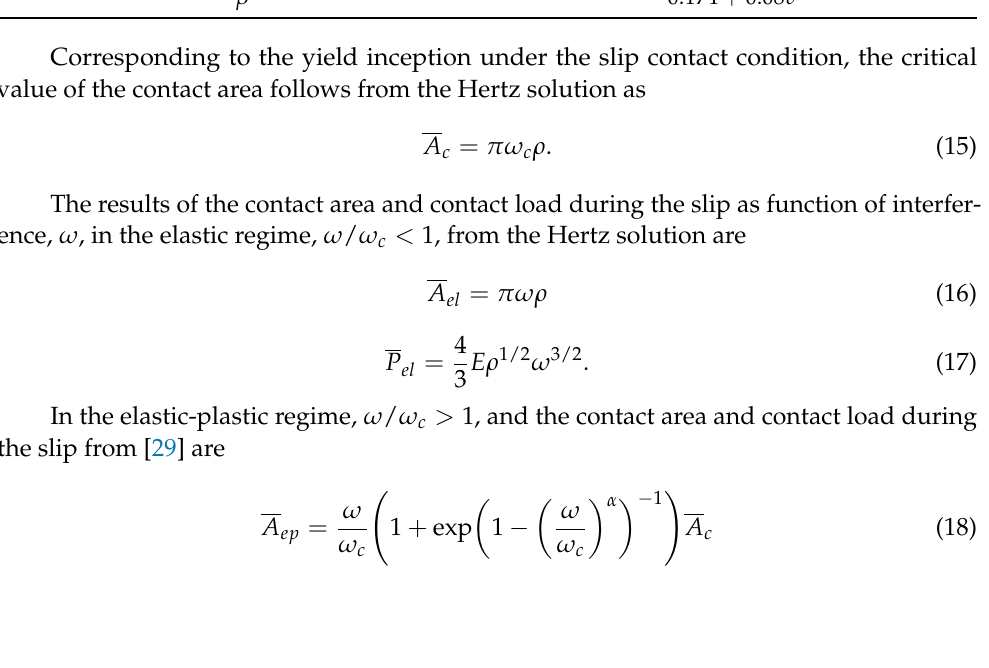
Table 1. List of functions of Poisson’s ratio [29]. Symbol Function C